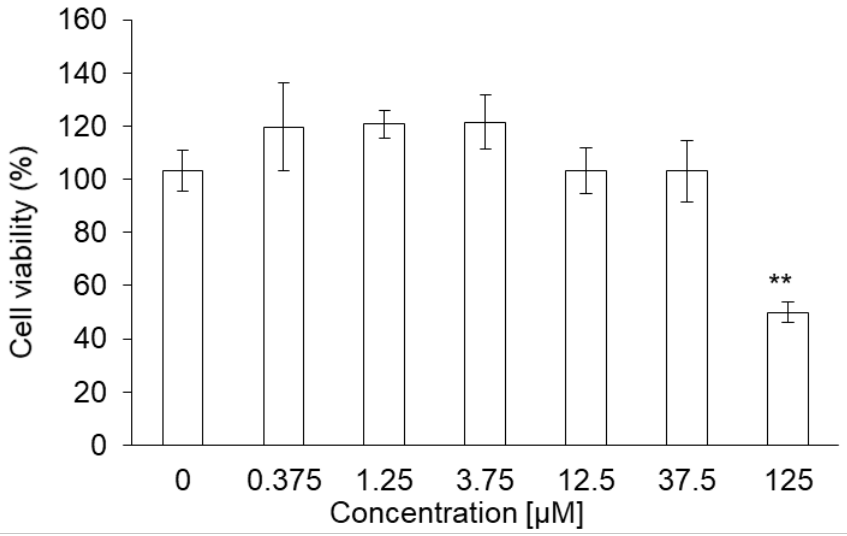
Figure 5. Cytotoxicity of PLP in NOZ cells. Data are expressed as means ± SD ( n = 5). ** p <